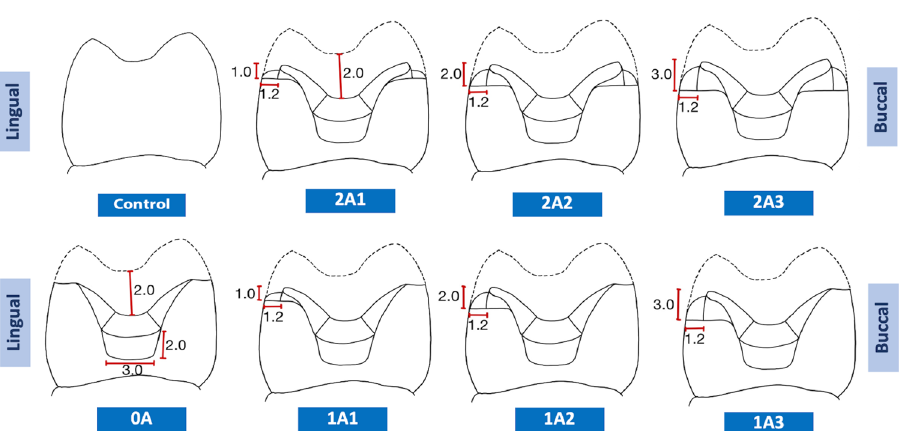
Figure 1. Illustrations of the various preparation designs in this